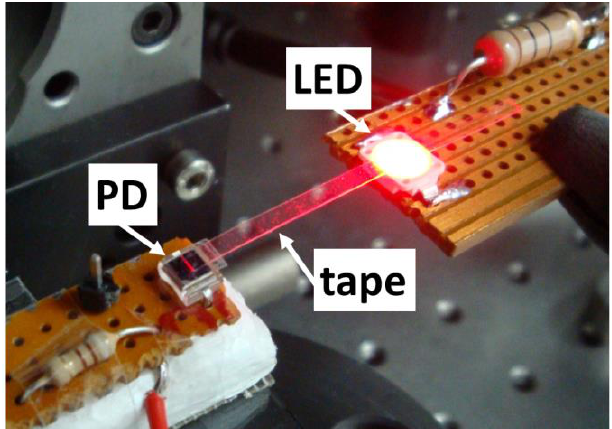
Figure 3. Photograph of the configuration and operation of the proposed flexible, adhesive tape-based optical link between a vertically emitting LED and a surface-normal photodiode (PD) for rapid on-site sensing applications. The tape waveguide integrates a 1D Al grating coupler (GC) that is placed on the LED radiative surface. The GC allows red light emitted by the LED to be coupled into the tape waveguide, whose tip end is attached to the PD detecting surface. The guided light reaches the PD where it is converted into an electrical signal. Red light propagation and scattering at the tip end on the PD are clearly observed.